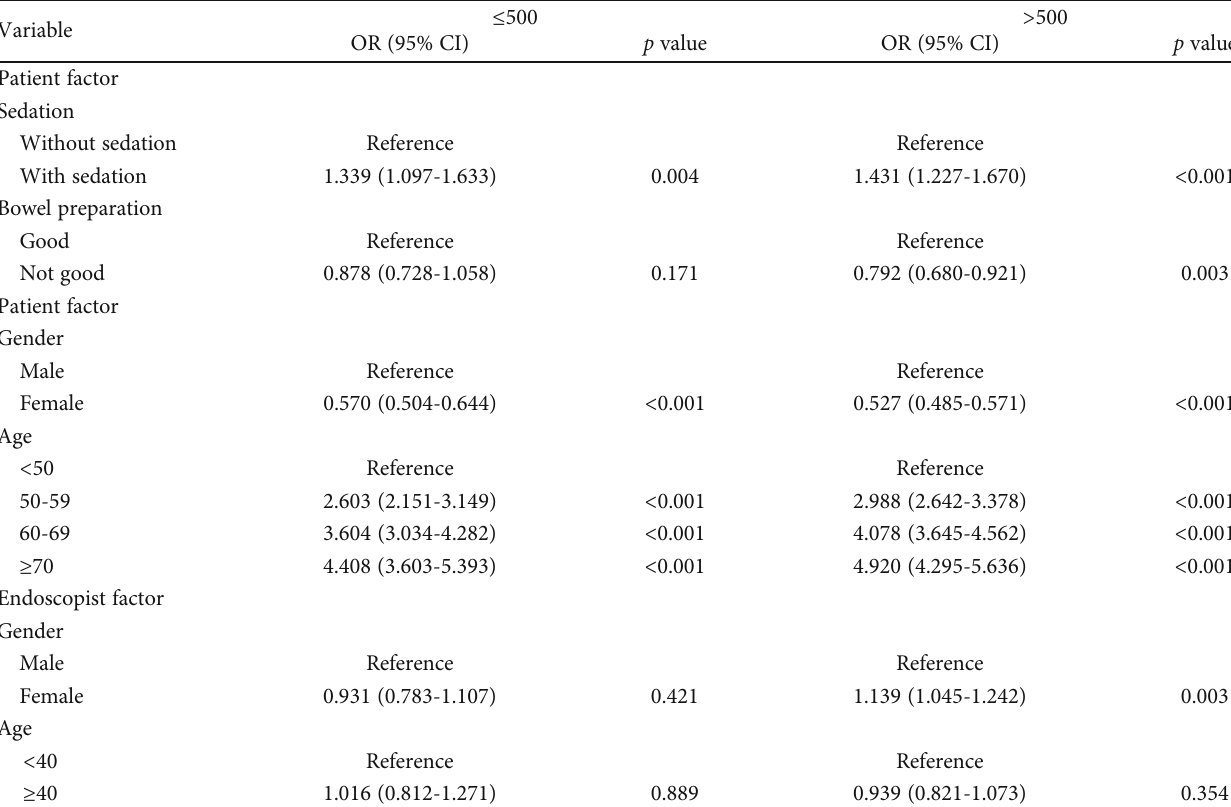
Table 3: Logistic regression analysis of risk factors for adenoma detection rate in subgroups strati fi ed by experience of colonoscopy.